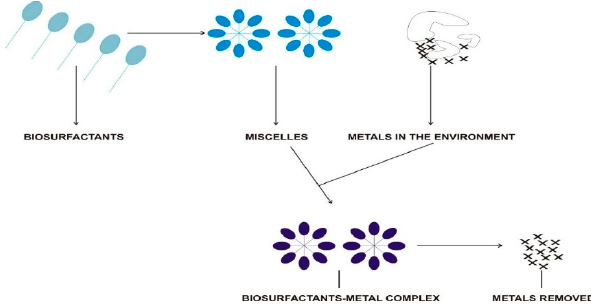
Figure 4. The removal of metals through the mediation of biosurfactants.